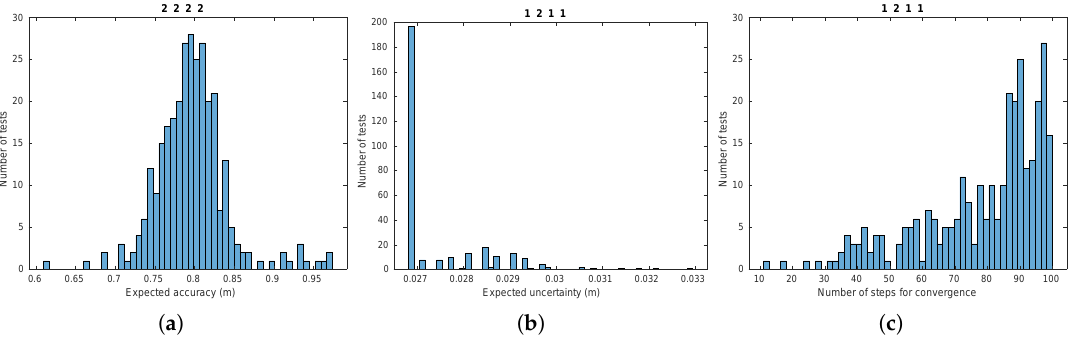
Figure 5. Histograms for some population groups corresponding to the three performances of the filter (refer to Appendix C for the rest). ( a ) Expected accuracy. ( b ) Expected uncertainty. ( c ) Convergence. Each sequence of four numbers in the figure titles represent the concrete combination of values for factors ABCD (see Table